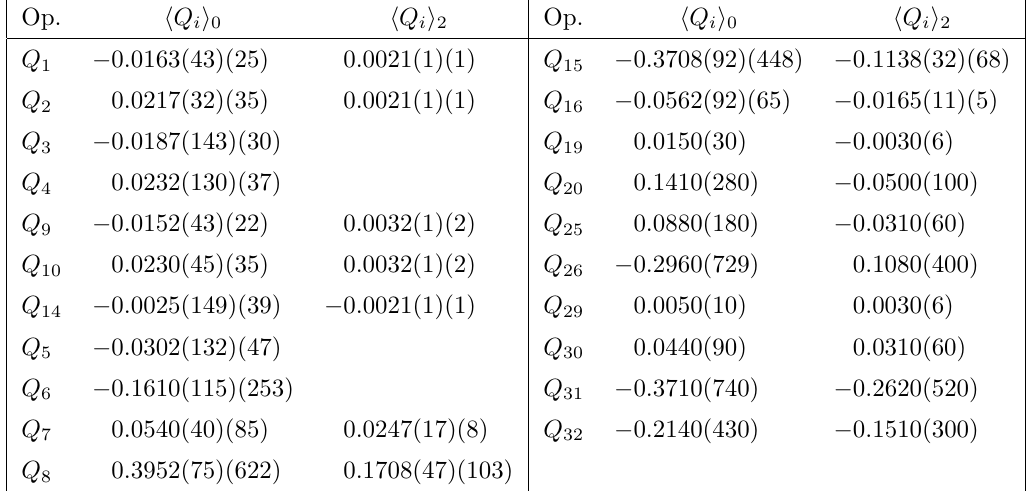
[GeV 3 ] for N = 3 BMU basis at scale µ = 1 . 3 GeV are i f i 0 , 2